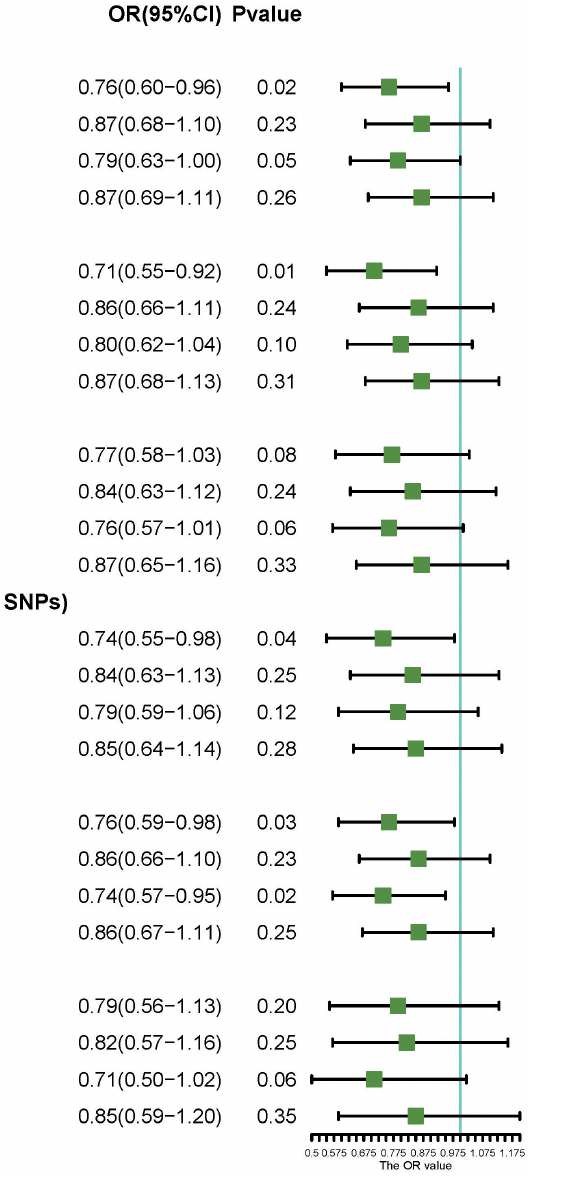
FIGURE 2 | Results of Mendelian randomization